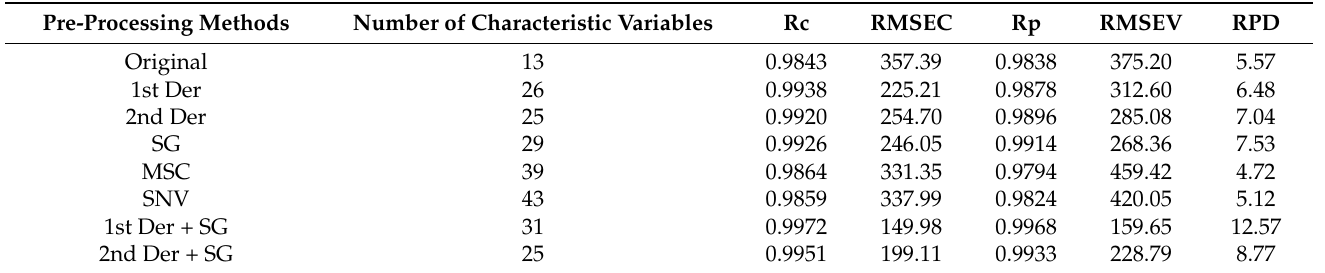
Table 4. Comparing PLSR results after extracting spectral features by a competitive adaptive reweighted sampling algorithm.